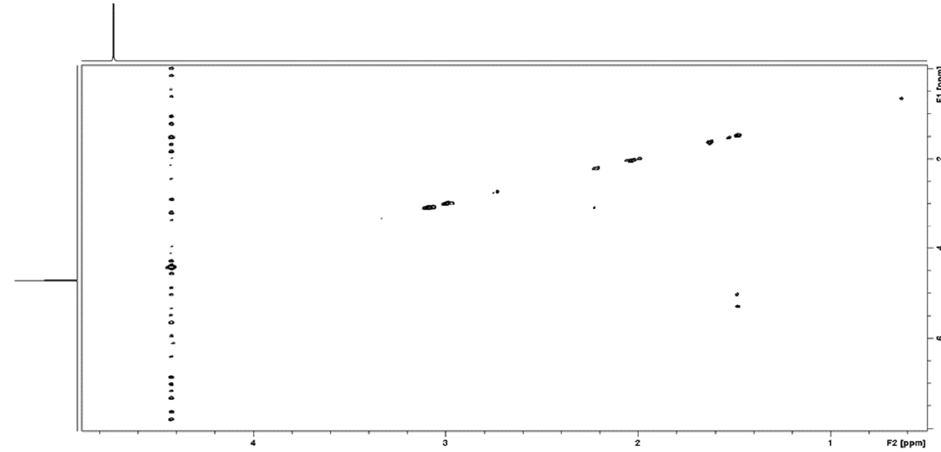
Figure 4. 1 H- 1 H COSY solution state NMR spectra of modified CS.